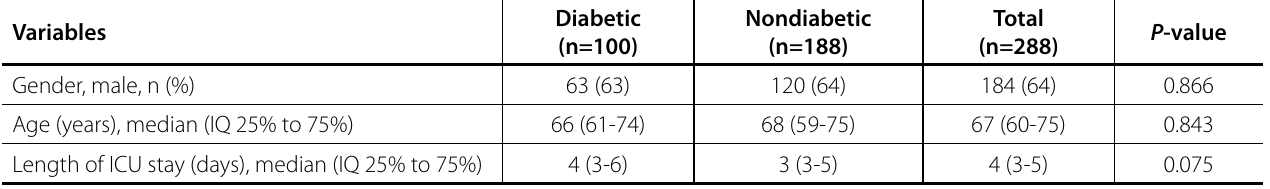
Table 1 . Demographic baseline characteristics of diabetic and nondiabetic patients.